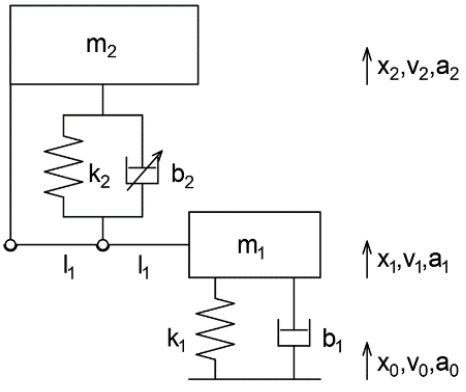
Figure 6. Numerical model.